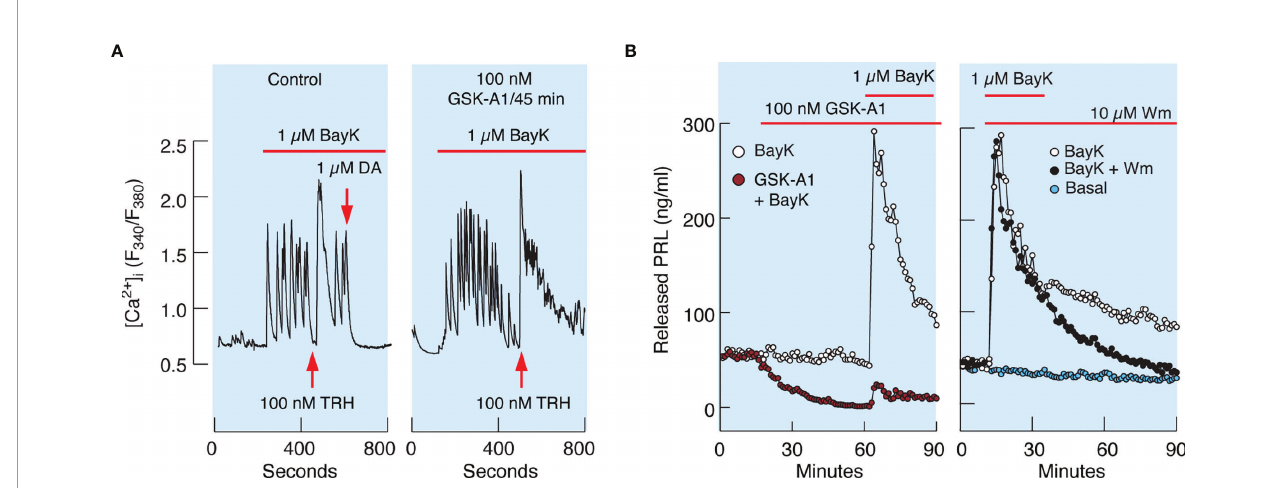
FIGURE 8 | Inhibition of PI4KA by GSK-A1 causes a decrease in BayK-induced PRL release downstream of facilitated voltage-gated calcium in fl ux. (A) BayK- stimulated voltage-gated calcium in fl ux (left) and lack of effect of GSK-A1 on the BayK-induced rise in [Ca 2+ ] i (right). Time of addition of TRH and Dopamine (DA) is indicated by the arrows. Traces shown are representative from three independent experiments. ( B , left) In cells treated with GSK-A1, basal PRL release was progressively reduced and BayK was unable to fully restore calcium – secretion coupling. Mean ± SEM values (ng/ml) during 20 min application: BayK 186 ± 12 vs . GSK-A1+BayK = 14 ± 1; P < 0.0001. ( B , right), When Wm and Bay K were applied together, the initial increase in PRL secretion was comparable to that of BayK- induced PRL release; mean ± SEM values (ng/ml) during 20 min application were 182 ± 11 (w/o Wm) vs . 176 ± 10 (with Wm). However, in Wm-treated cells, BayK- stimulated PRL release gradually declined, with a rate comparable to that of the inhibition of basal PRL release shown in the left panel, in contrast to control ( Figure 9D ) treated cells. Administration of 1 µM PIK93, a PI4KB inhibitor, was ineffective ( Figures 9C, D ). Therefore, functional PI4KA is also critical for the release of PRL induced by calcium mobilization.